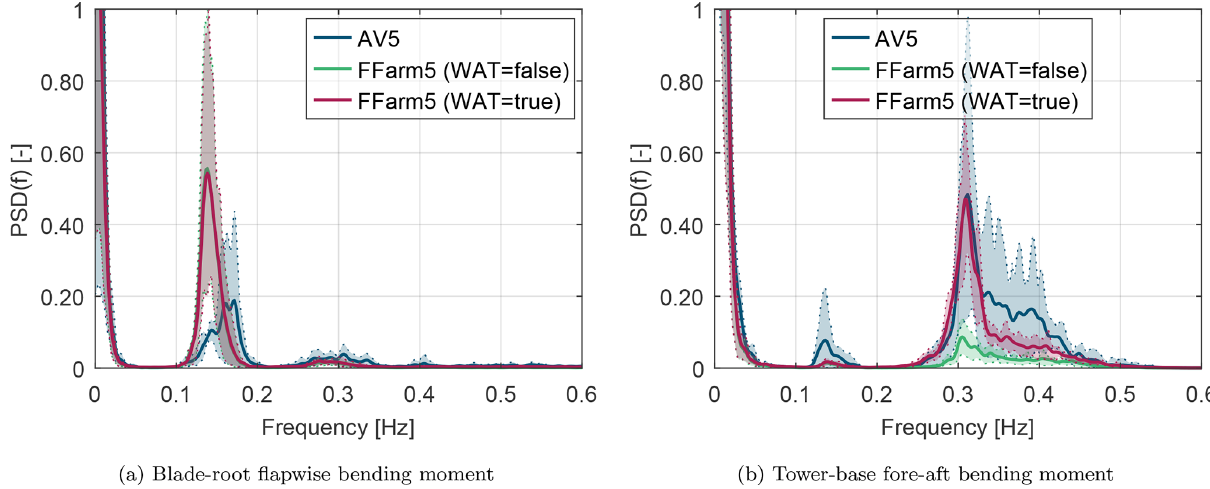
Figure A2. Comparison of power spectral densities (PSD) between measurements (AV5) and FAST.Farm simulations with activated (WAT = true) and deactivated (WAT = false) wake-added turbulence for wind speeds of 7.5–8.5ms − 1 (wind direction 270.75–273.25 ◦ ). Thick lines show the mean of the PSDs for all considered events. The shaded area indicates the 15th and 85th percentiles.